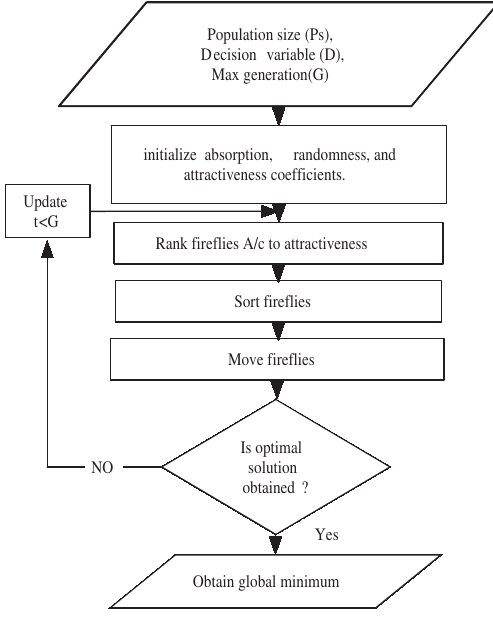
Figure 2. Basic Firefly Algorithm